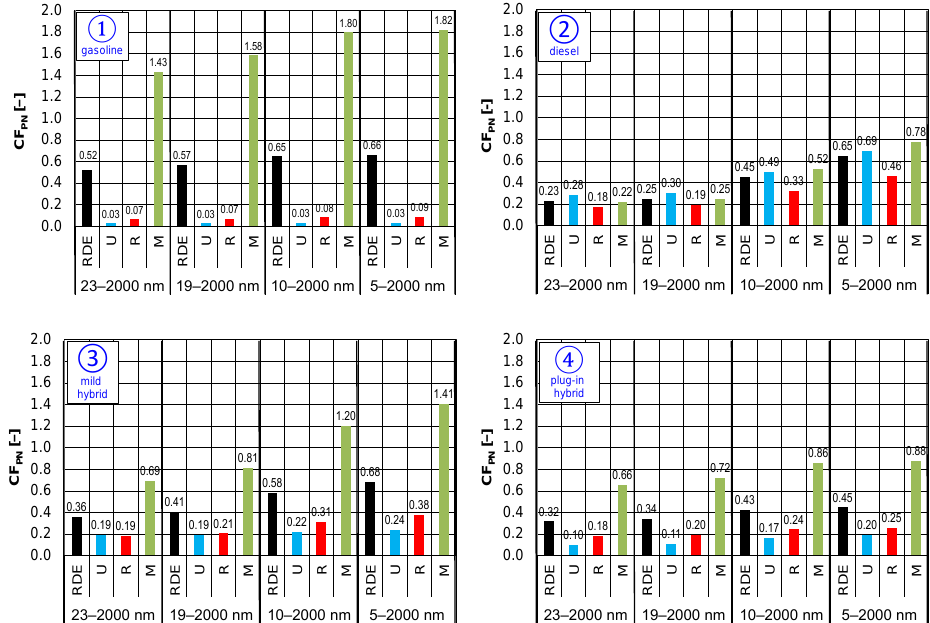
Figure 14. Conformity factor for the number of particles for vehicles 1 – 4 in the RDE test and its individual parts (urban, rural, motorway), along with a division of the diameters considered; 1 — gasoline, 2 — diesel, 3 — mild hybrid, 4 — plug-in hybrid.